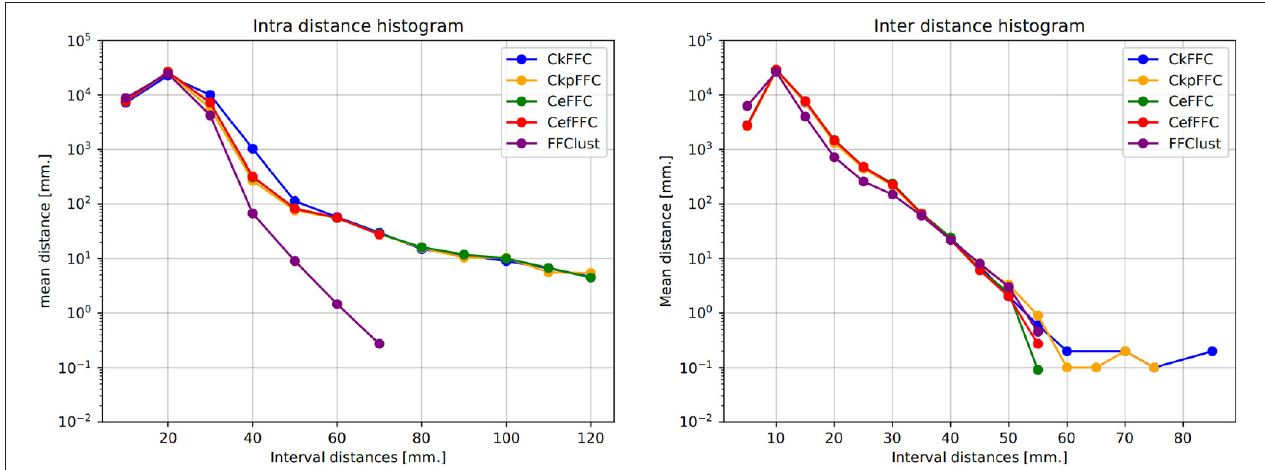
FIGURE 4 | Intra-cluster and Inter-cluster distance histograms of final clusters. Intra-cluster distance shows that the parallel alternatives achieve less compact clusters than FFClust. Inter-cluster distance shows that parallel alternatives have fewer clusters that are closer to each other than FFClust.